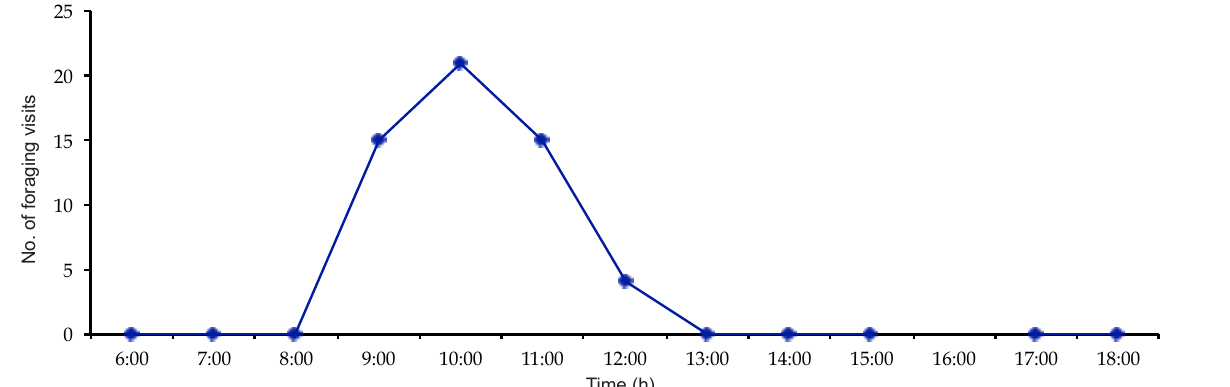
Figure 2: Hourly foraging activity of wasps on Boswellia ovalifoliolata